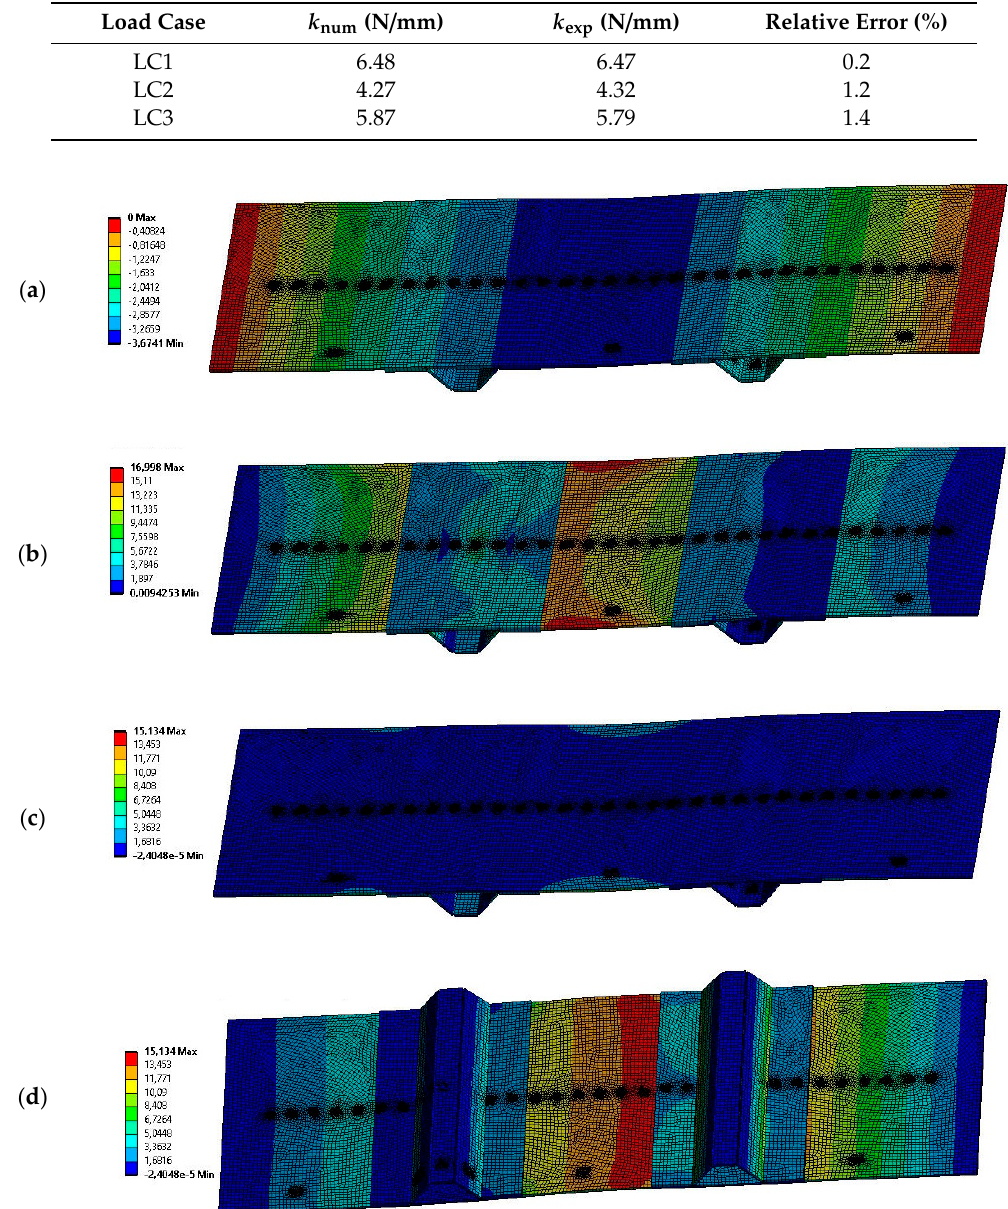
Figure 8. Example numerical results (20 N of force applied at point LC1): ( a ) directional deformation along axis Y ; ( b ) von Mises stress; ( c ) maximum principal stress (view from top); and ( d ) maximum principal stress (view from bottom).